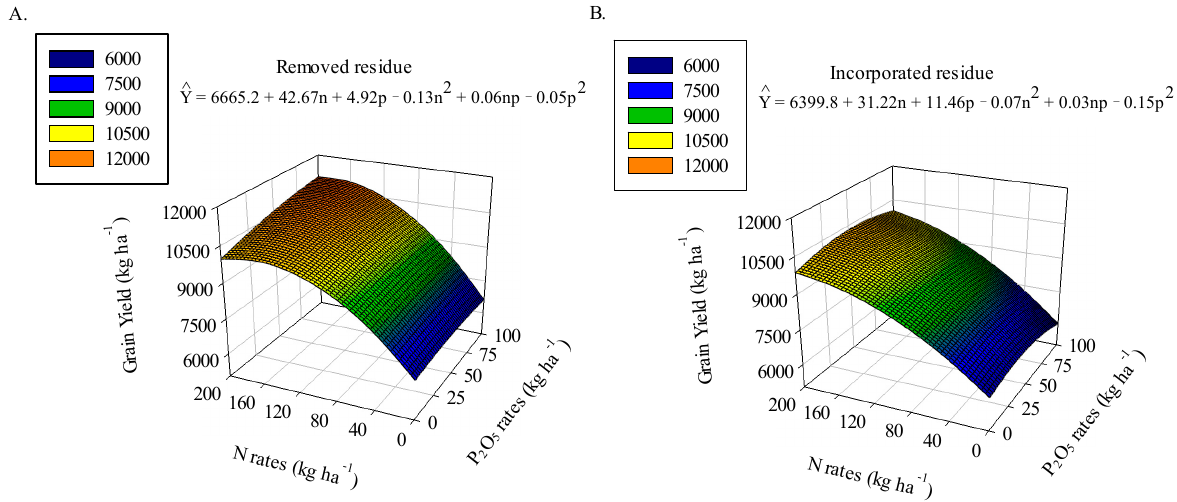
Figure 2. Grain yield under removed ( A ) and incorporated ( B ) residue management in 2013 and 2014 as a function of N and P 2 O 5 rates.